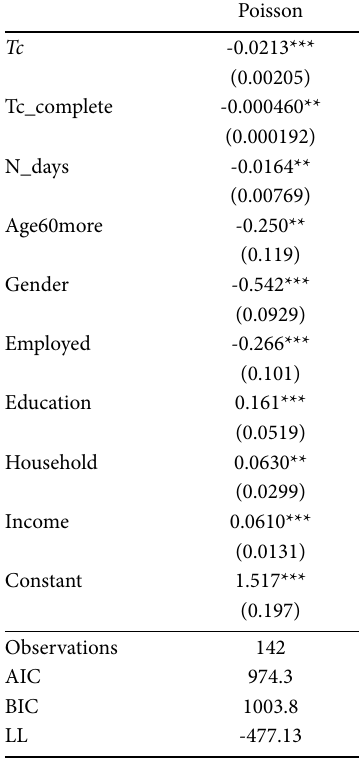
Table 4. Results of the different